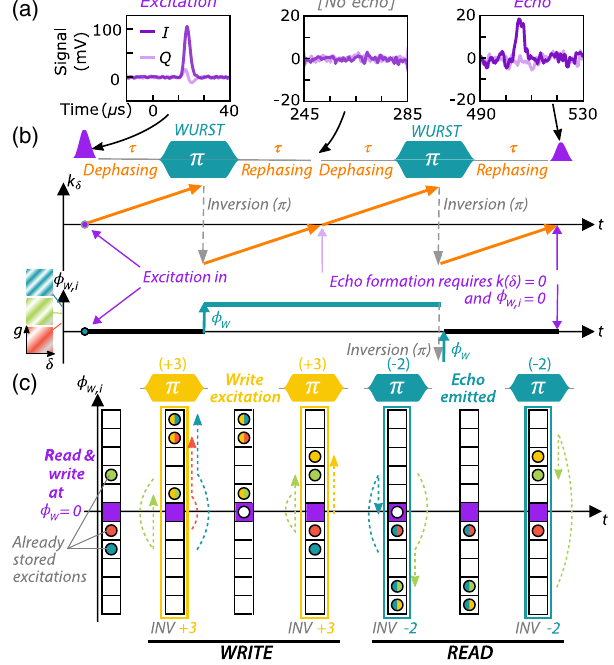
FIG. 1. Using chirped pulses to silence echoes and encode quantum information. (a) A weak ( h n i ∼ 200 photon) Gaussian microwave excitation is applied to an ensemble of Bi donor spins in silicon followed by two chirped “ WURST ” π pulses (chirp rate 20 MHz = ms 200 μ s duration). A spin echo is observed only after the second WURST pulse. The demodulated I and Q quadratures are shown. (b) The WURST pulse (index i ) inverts the phase of the ensemble and imprints a phase pattern ϕ in the space of the W;i atom-cavity coupling g 0 , and the frequency detuning δ . k δ